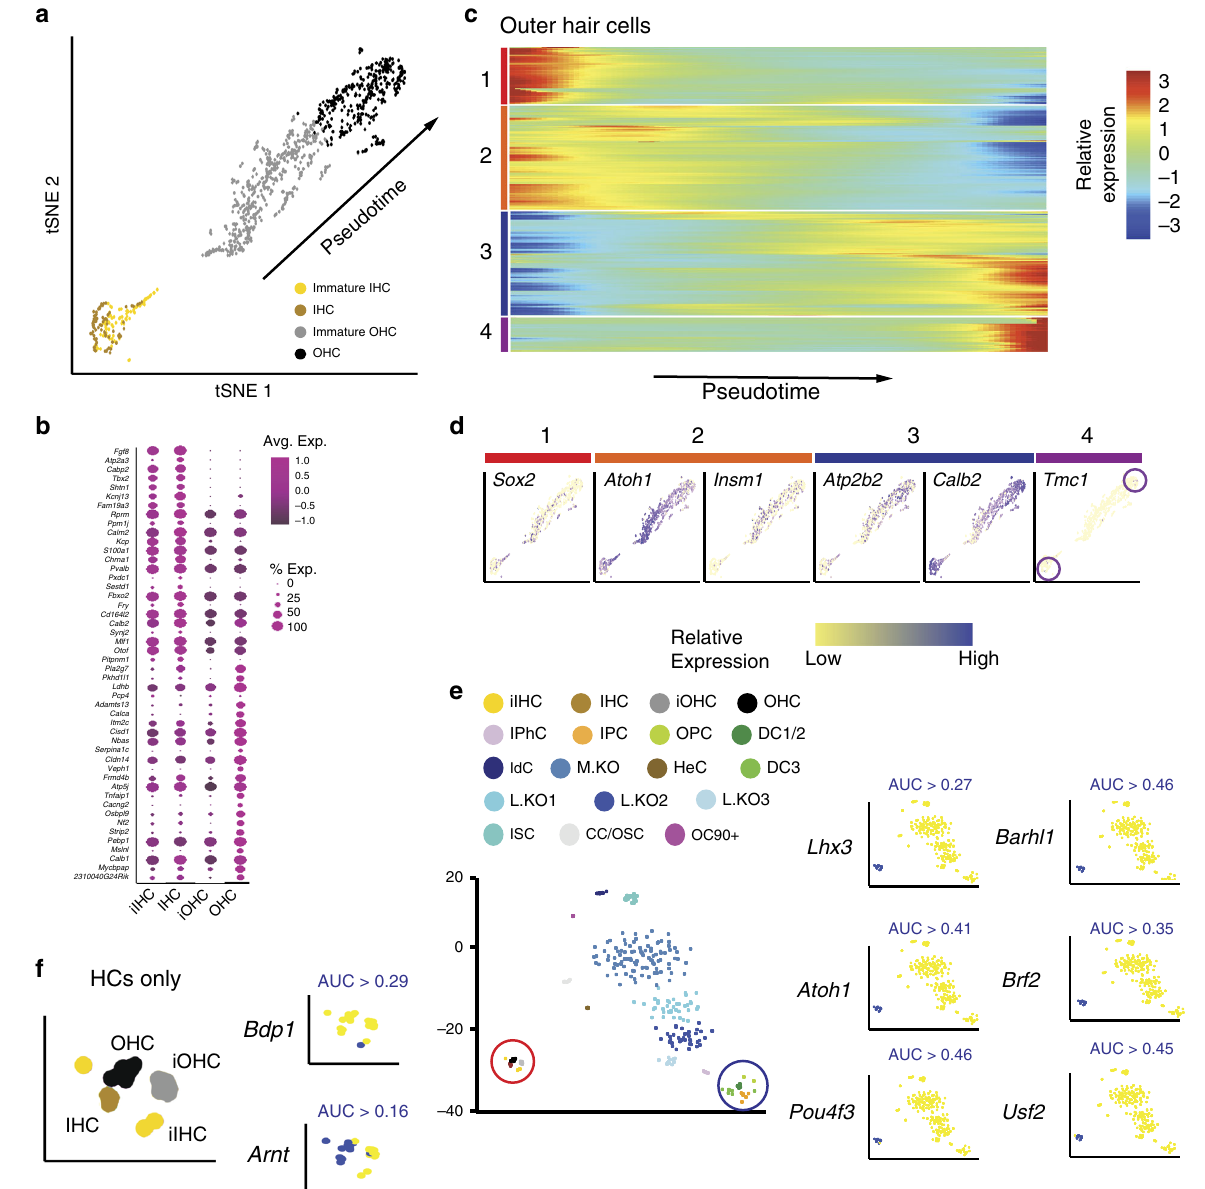
Fig. 3 Development of OHCs. a t SNE plot for HCs isolated at P1. Both IHCs and OHCs can be clustered into immature and more mature cell groups based on gene expression. Arrow indicates trajectory of pseudotime (see c , d ). b Dot plot showing differentially expressed genes between IHCs and OHCs. IHCs exclusively express several genes, including Fgf8 , Atp2a3 , Cabp2 , Tbx2 , and Shtn1 . In contrast, a more limited number of genes are exclusively expressed in OHCs, including Calca , Serpina1c , Veph1 , Cacng2 , Strip 2, and Msln1 . This may re fl ect the delay in OHC maturation relative to IHC. c The P1 OHCs were analyzed using Monocle to generate a pseudotime trajectory. Analysis of gene expression pro fi les along pseudotime identi fi ed four different developmental phases. d Feature plots for a representative gene or genes from each of the four OHC developmental phases. Expression of Tmc1 was limited to the most mature IHCs and OHCs (purple circles) e Left-hand panel, t SNE plot based on identi fi cation of transcriptional regulons using SCENIC. The HC and SC clusters are indicated by red (HC) and blue (SC) circles. Right-hand panel, feature plots for representative HC-speci fi c regulons (blue indicates high expression). Lhx3, Atoh1, Pou4f3, and Barhl1 are known HC-speci fi c transcription factors (TFs). Brf2 and Usf2 have not been previously localized to hair cells but are present in HCs from previous bulk RNAseq experiments (see text). f Left-hand panel, expanded regulon t SNE for the HCs. Right-hand panel, two additional TFs, Bdp1 and Arnt1 are localized to HC subsets. HC hair cells, IPhC inner phalangeal cells/border cells, IPC inner pillar cells, OPC outer